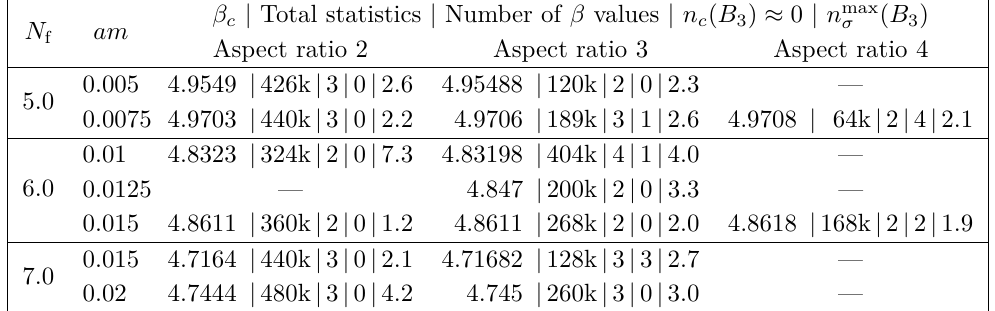
Table 6. Statistics overview for N τ = 8 .